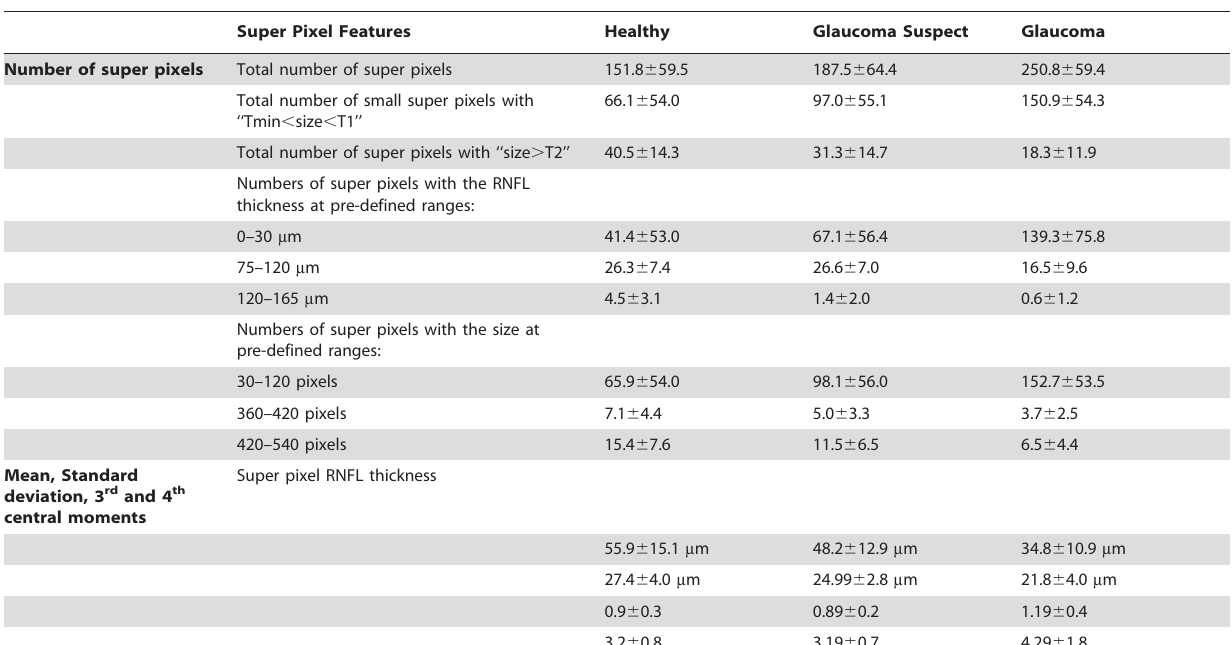
Table 1. Super pixel features used as inputs for the machine learning